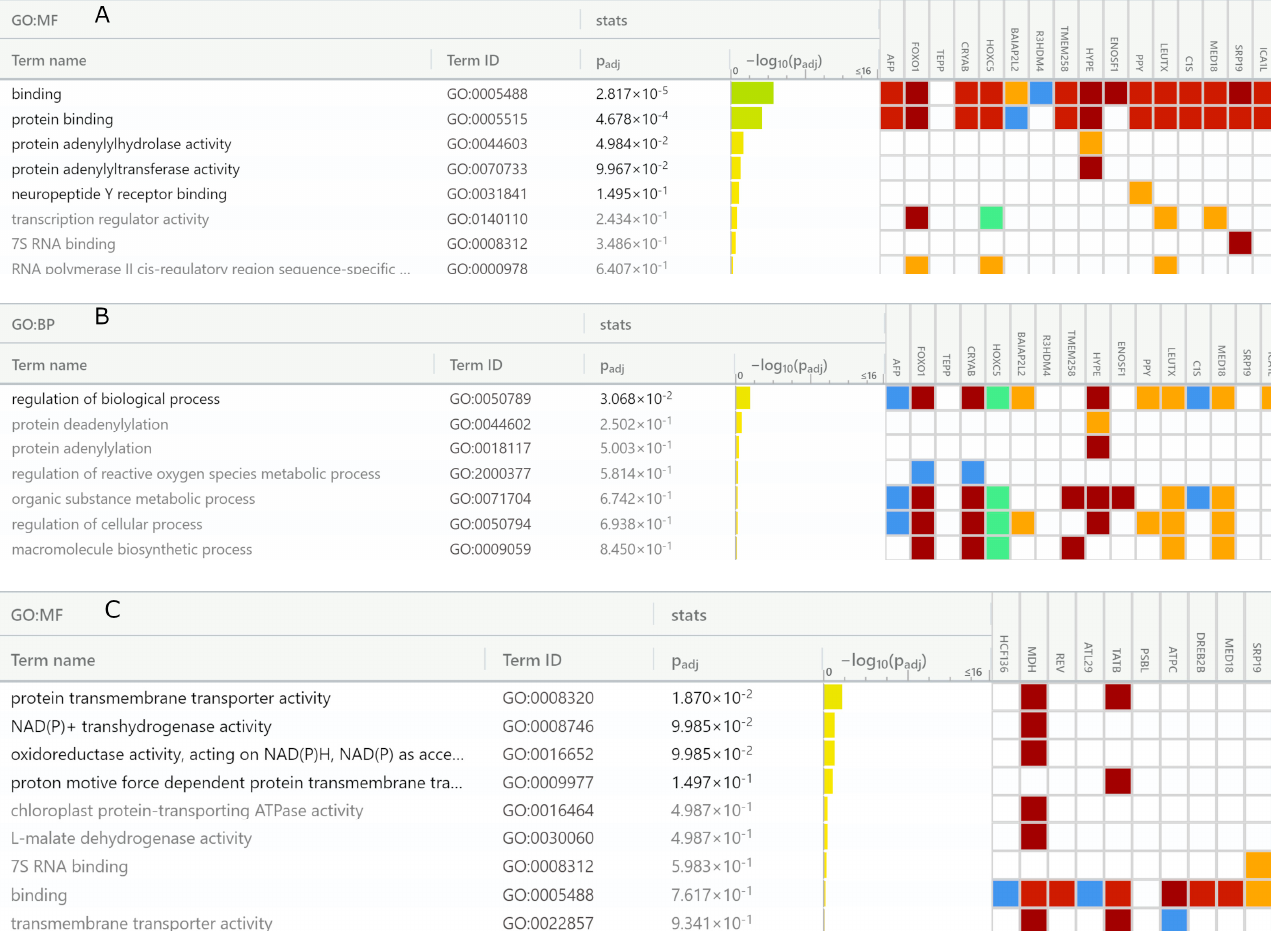
Figure 9. H. sapiens and A. thaliana gene set enrichment analysis of GIP-9-like motif-containing pro- teins. Human genes categorized in ( A ) molecular function terms and ( B ) biological process terms. A. thaliana genes categorized in ( C ) molecular function terms and ( D ) biological process terms. Color codes indicate data inferred from: dark brown—experiment/direct assay, light brown—genetic and physical interactions, yellow—sequence similarity, dark purple—high throughput experiment, green—curator, blue—reviewed computational data. 4. Discussion SLiMs are often found in the rapidly evolving intrinsically disordered regions of pro- teins and the motif acquisition can proceed through the convergent evolution [92]. Fre- quent mutations, small size, and low complexity make it difficult to identify motifs and to study their functions. Here, we used bioinformatics and GO enrichment analyses to search for SLiMs with sequence similarity to two AFP-derived sequences, LDSYQCT (AFP 14–20 ) and EMTPVNPGV (GIP-9). We identified a vast array of similar motifs across all taxo- nomic categories including bacteria, viruses, archaea, and various eukaryotic species. One of the most prominent molecular functions of human and rodent AFPs is metal ion binding capability [93], which is similar to activities of majority of the retrieved in our study proteins. This capability underlies the involvement of proteins in various cellular processes including metabolism, transcriptional regulation, and redox regulation. Most of prokaryotic proteins were, unsurprisingly, involved in nucleotide, nucleic acid, amino acid, and protein biosynthesis necessary for their reproduction. However, the overwhelm- ing majority of both prokaryotic and eukaryotic proteins including enzymes, transcription factors, quality control, and ribosomal proteins were involved in the cellular adaptation to environmental changes and various stress conditions. Our data suggest that AFP can use the SLiMs of interest to provide cellular adaptation to stress conditions during embry- onic development and cancer growth.